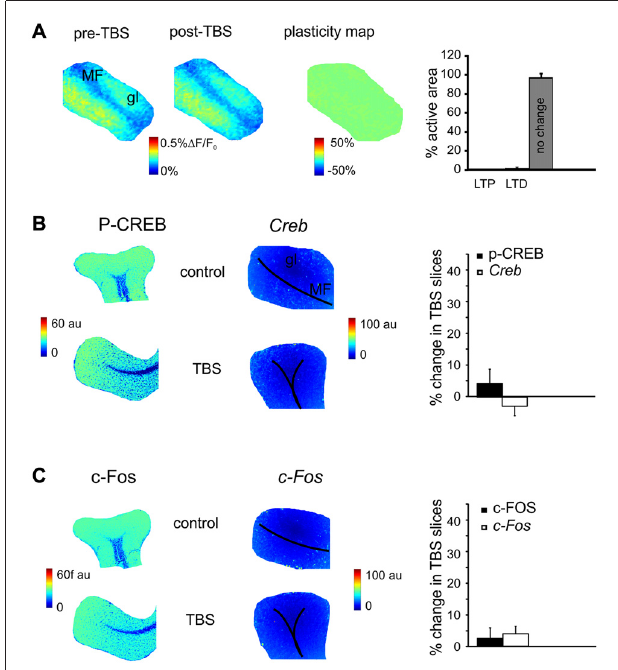
FIGURE 4 | The effect of N-methyl-D-aspartate receptor (NMDAR) blockade on the long-term plasticity, gene expression and protein synthesis. (A) In the presence of 2-amino-5-phosphonovaleric acid (APV), the plasticity map (that was obtained as in Figure 1 ) shows that TBS does no longer induce synaptic plasticity. The histogram confirms the almost complete absence of changes in the slice. (B) In the presence of APV, the pseudocolor maps of P-CREB and Creb levels (that were obtained as in Figure 2 ) do not show remarkable differences between a control slice and a slice that has received TBS. Histograms show that no significant differences occur between control slices and slices that have received TBS (mean and SEM, n = 4; 120 min). (C) In the presence of APV, the pseudocolor maps of c-FOS and c-Fos levels (that were obtained as in Figure 2 ) do not show remarkable differences between a control slice and a slice that has received TBS. Histograms show that no significant differences occur between control slices and slices that have received TBS (mean and SEM, n = 4; 120